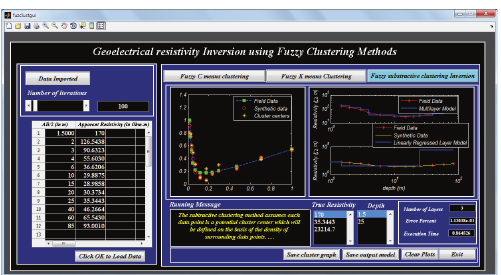
Figure 7: GUI panel showing the fuzzy subtractive clustering inversion for data